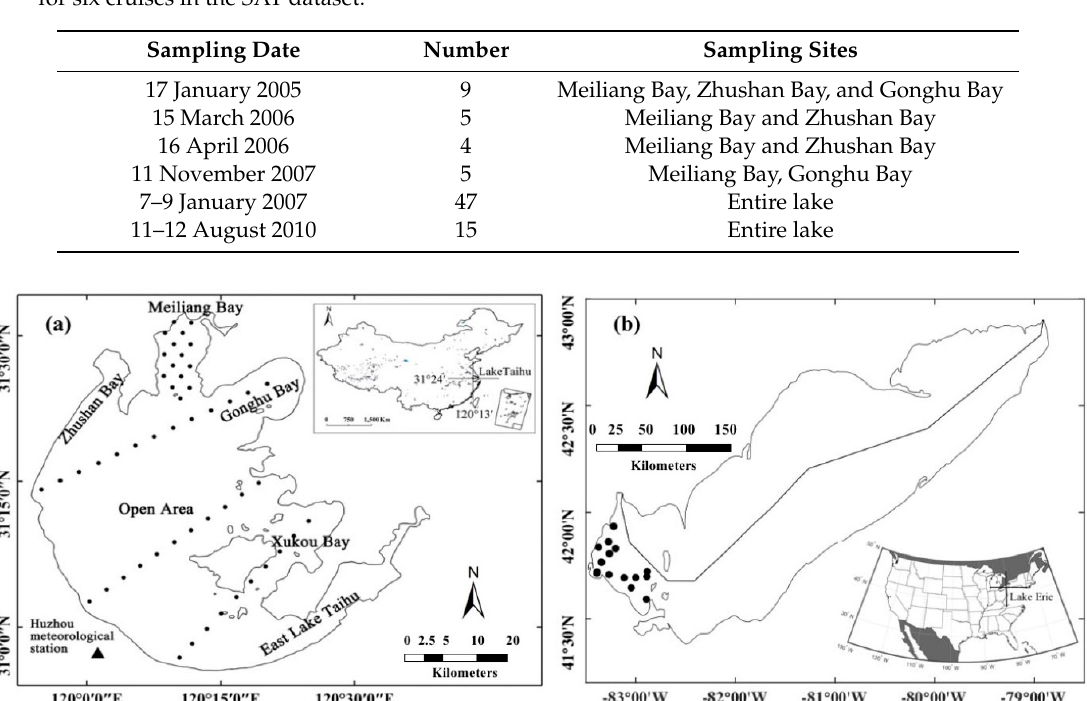
Table 2. Sampling date, number of samples, and distribution of concurrent sampling sites with MERIS for six cruises in the SAT dataset.